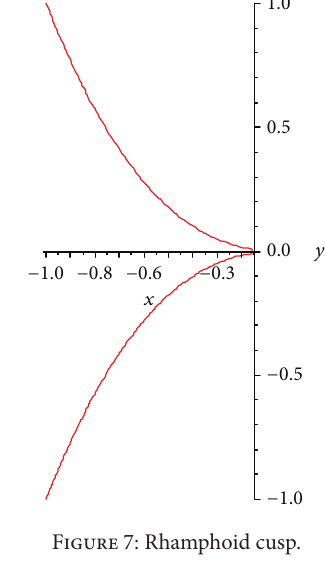
Figure 5: Ordinary cusp.